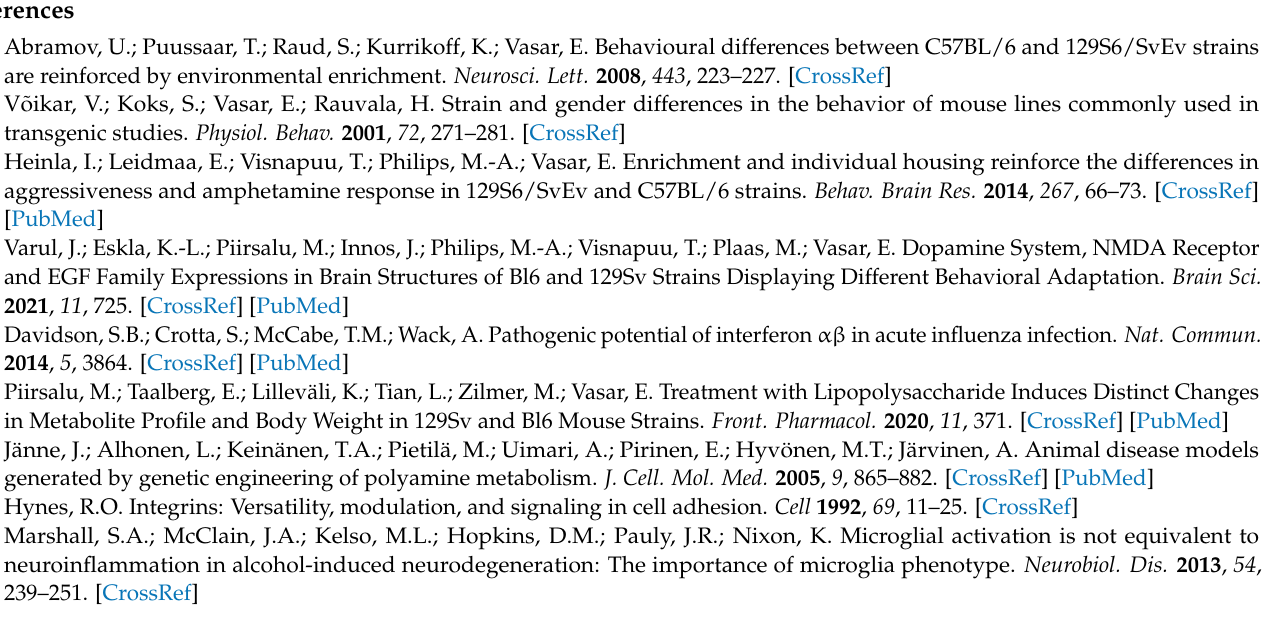
parameters; Table S2: Pearson’s correlation coefficient matrices of MHC-I gene expression and bodyweight ( ∆ BW) and body temperature ( ∆ BT)